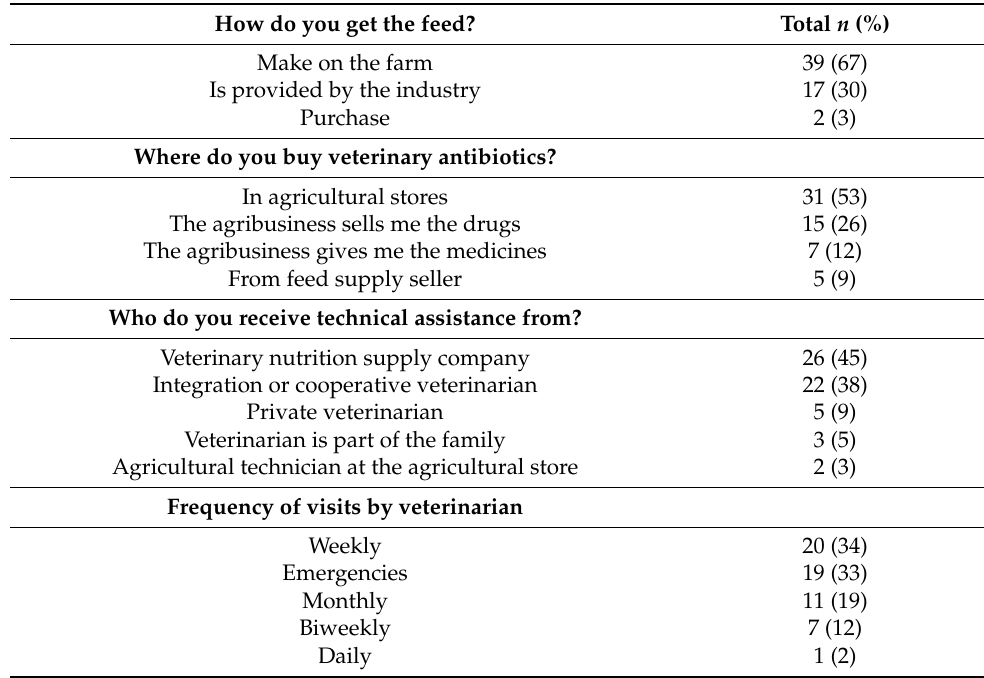
Table 6. Information on feed purchase and technical